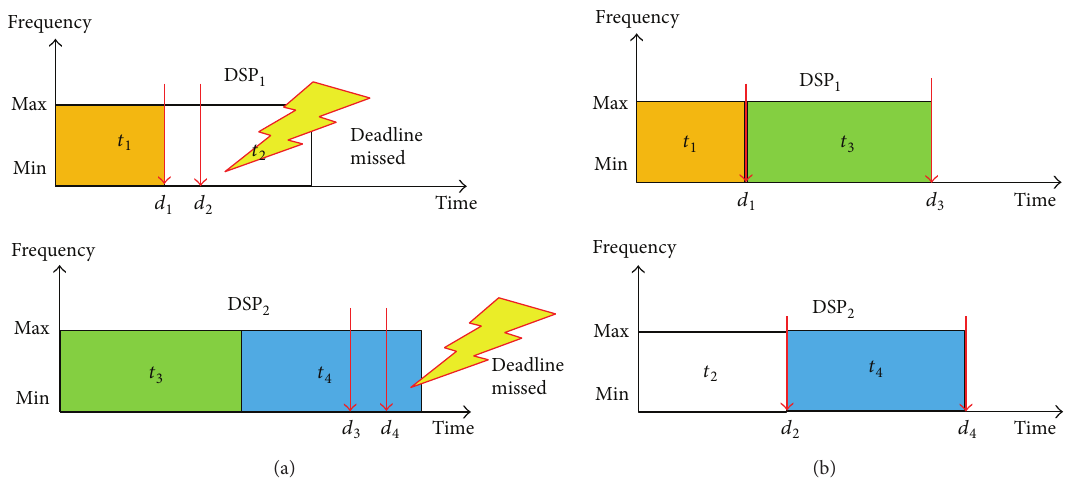
Figure 6: Example of load unbalance. (a) Initial state, (b) Task 1 released and turning on DSP 1 . (c) Task speed and turning on DSP 2 . (d) DSP 1 finished all of tasks that dispatched to it and turning off DSP 1 .